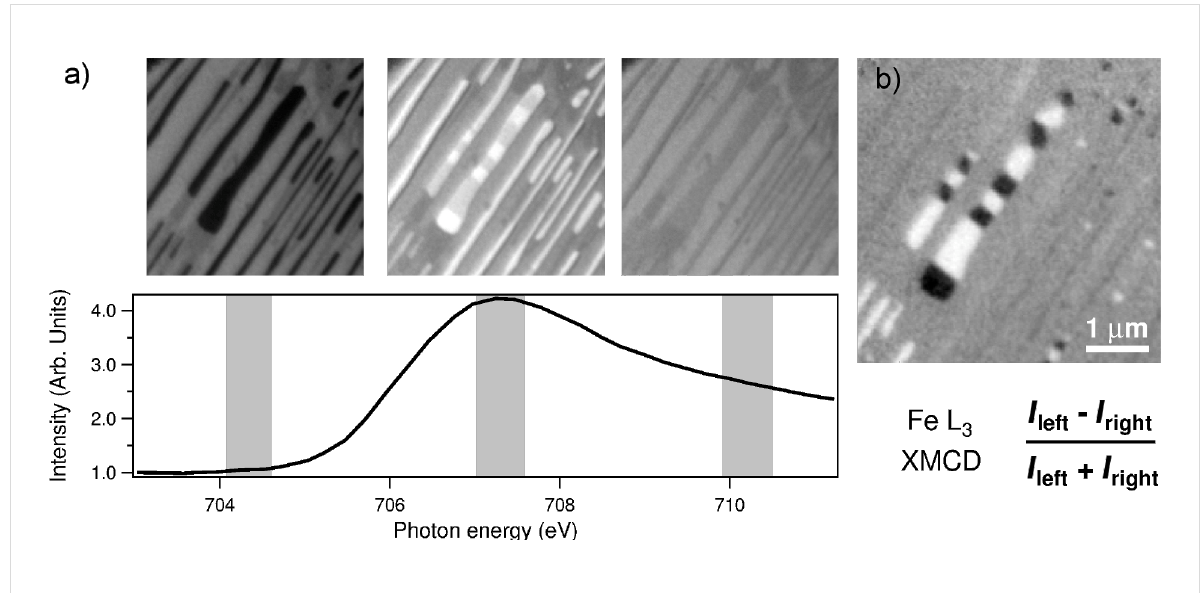
Figure 3: a) Illustration of imaging spectroscopy in XAS mode. Fe nanowires on W(110) appear dark on the left panel at a photon energy of 704.5 eV. At the Fe L 3 threshold, the wires become much brighter (middle panel). The XAS spectrum below is extracted from the largest nanowire in the center. b) Illustration of XMCD-PEEM imaging. The photon energy is tuned to the L 3 maximum. The field of view is 5 μ m. The start voltage is 3 eV in order to collect secondary electrons. Within the image plane, the X-ray direction is perpendicular to the nanowire